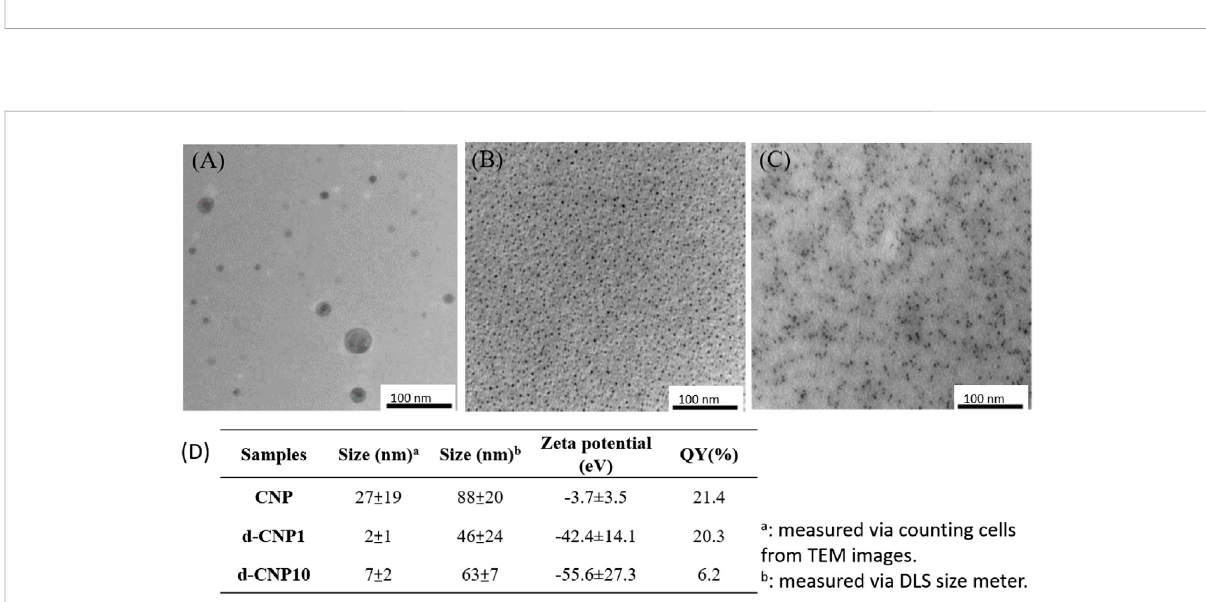
Characterization of CNPs. (A) XRD diffraction spectrum and the related JCPDS for carbon materials (inset). (B) IR spectra of CNP, d-CNP1, and